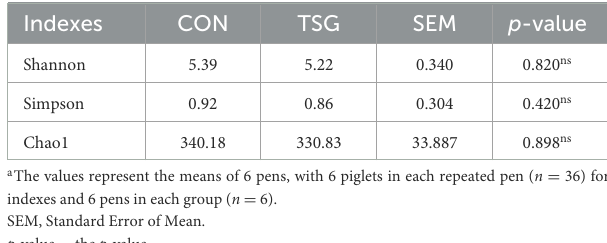
TABLE 3 Effects of transportation stress on richness and diversity of jejunum in weaned piglets a